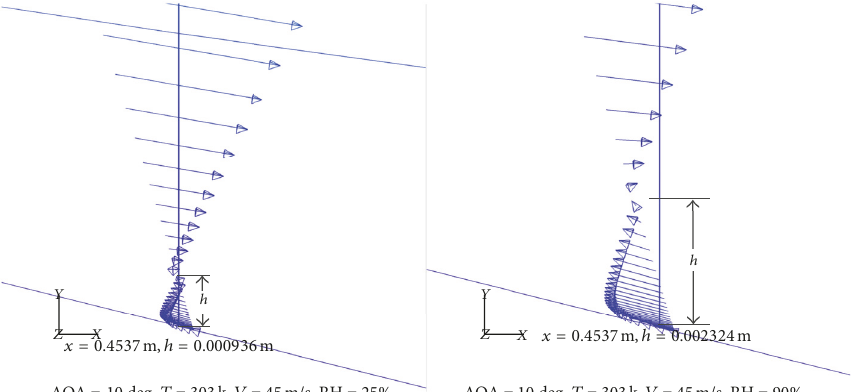
Figure 9: Vectors of air velocity for AOA = 10 degrees (EWF model).